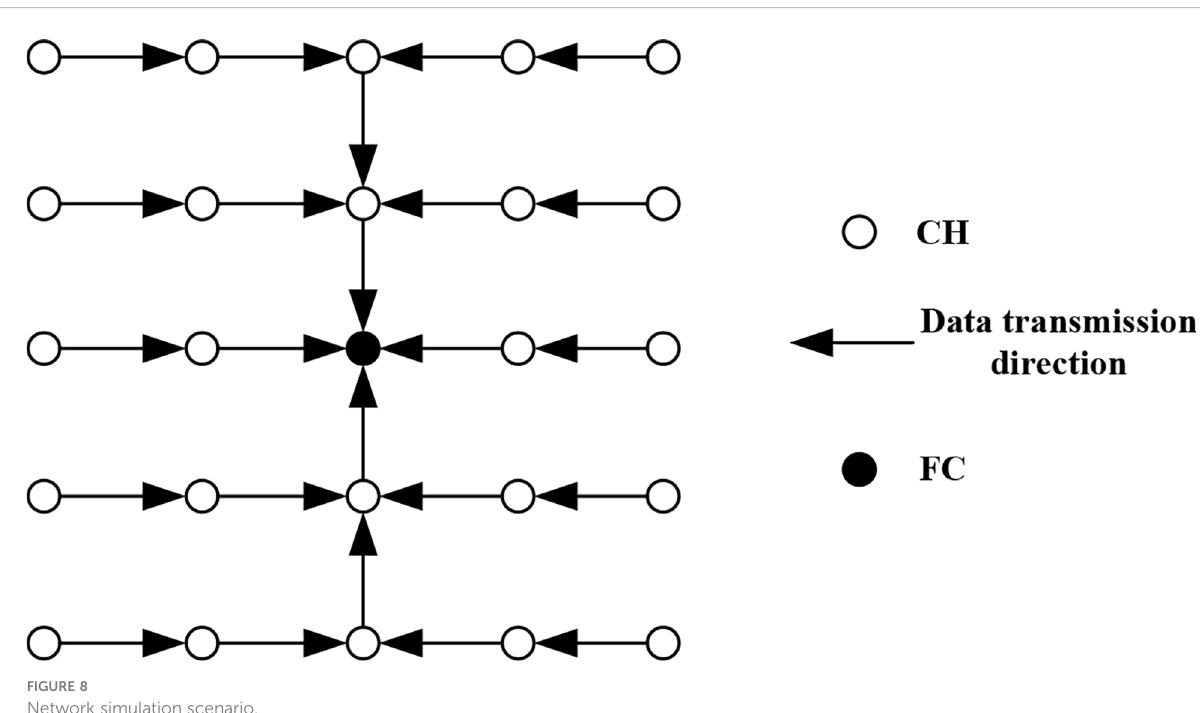
FIGURE 8 Network simulation